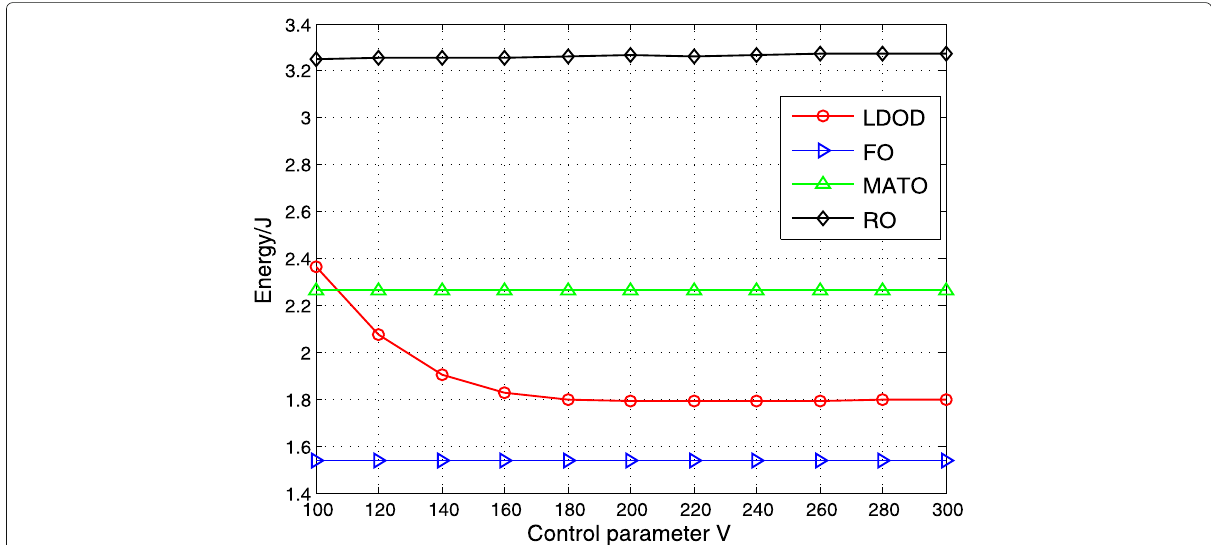
Fig. 14 The average energy consumption versus V with the proposed algorithm, MATO algorithm, and RO and FO